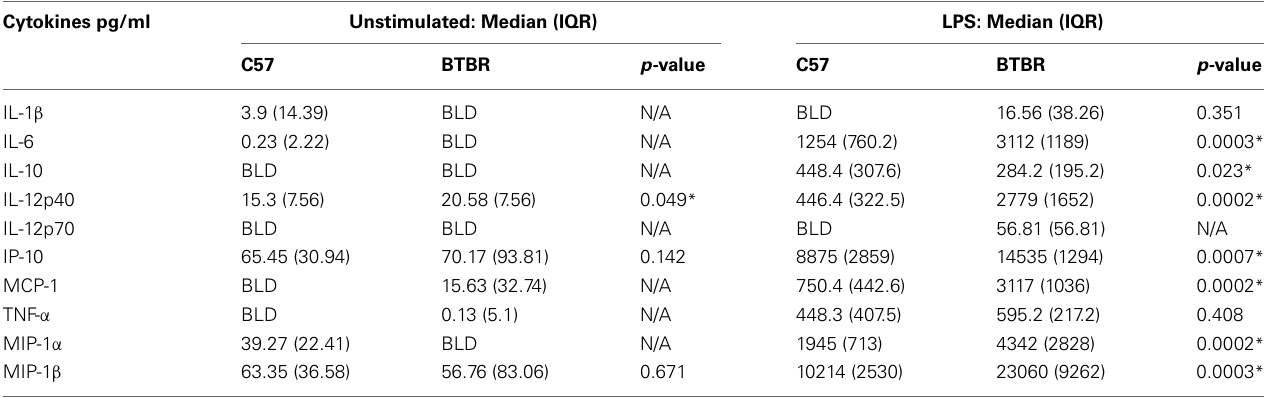
Table 1 | Macrophage cytokine levels in unstimulated and LPS stimulated culture conditions. Cytokines